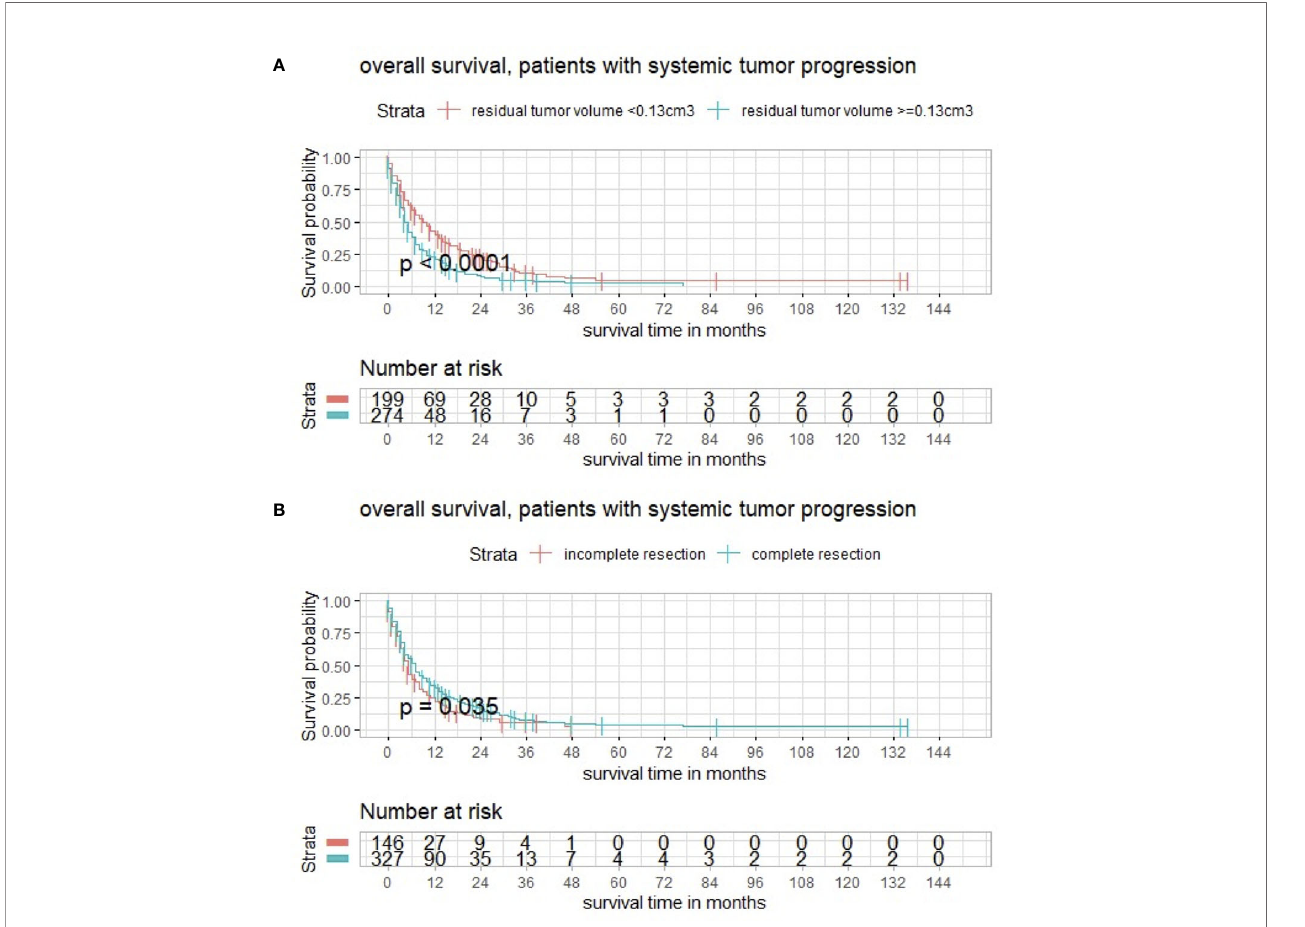
FIGURE 3 | (A) Maximally selected log rank statistics displaying the cutoff of postoperative tumor volume in a subgroup with systemic tumor progression. (B) Functions of overall survival demonstrating signi fi cantly divergent survival curves after complete surgical